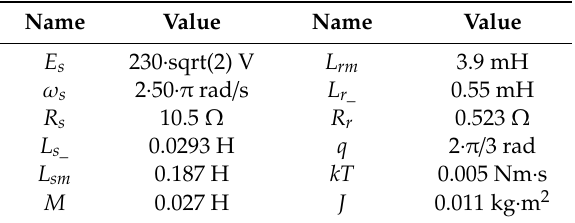
Table 1. Parameters of the modeled induction motor.